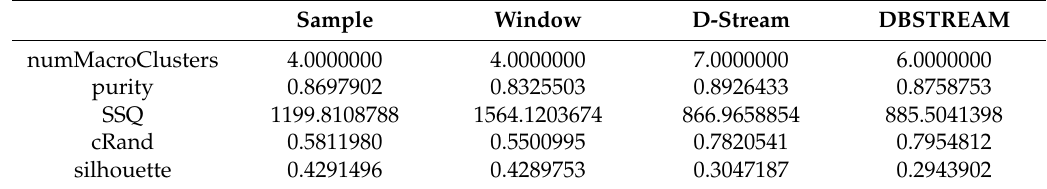
Table 5. Evaluation Results for generated data streams.